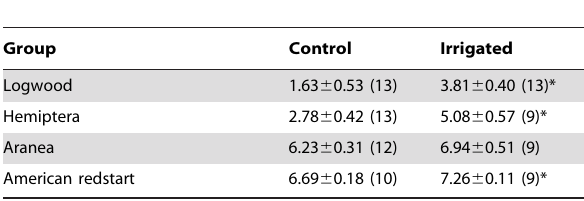
Table 1. Nitrogen-15 isotope values for four taxonomic groups on control and irrigated plots at Font Hill,